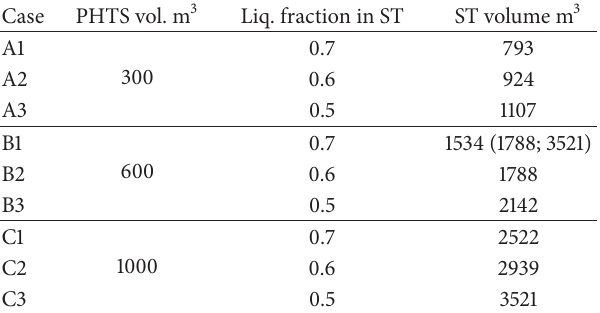
Figure 4: VVPSS schematic model in CONSEN calculations. Table 3: Sensitivity analyses to evaluate the pressure peak in the